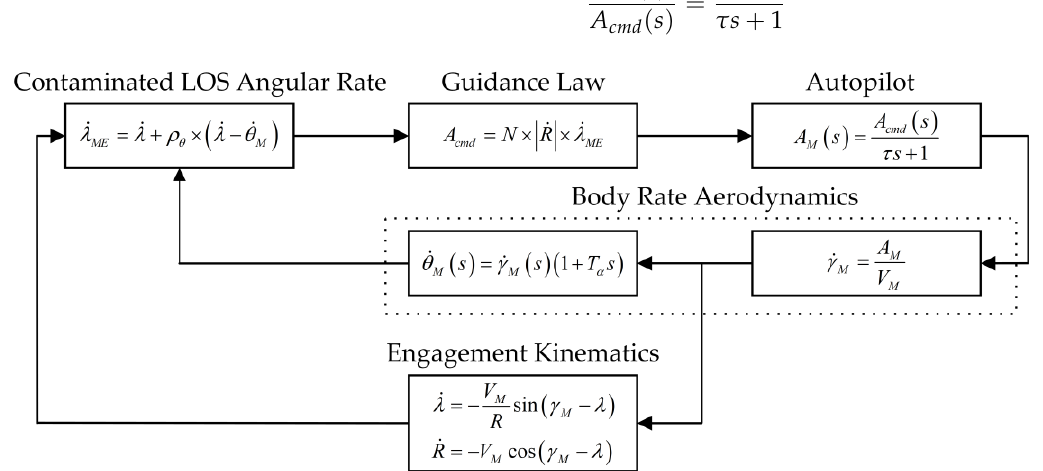
Figure 3. PN guidance system considering the radome refraction effect.